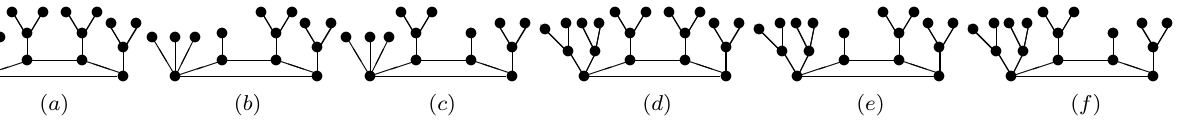
Fig.8. Six possible graphs on G with the proof of Lemma 3.12 Figure 8. ( a – f ) Six possible graphs on G with the proof of Lemma